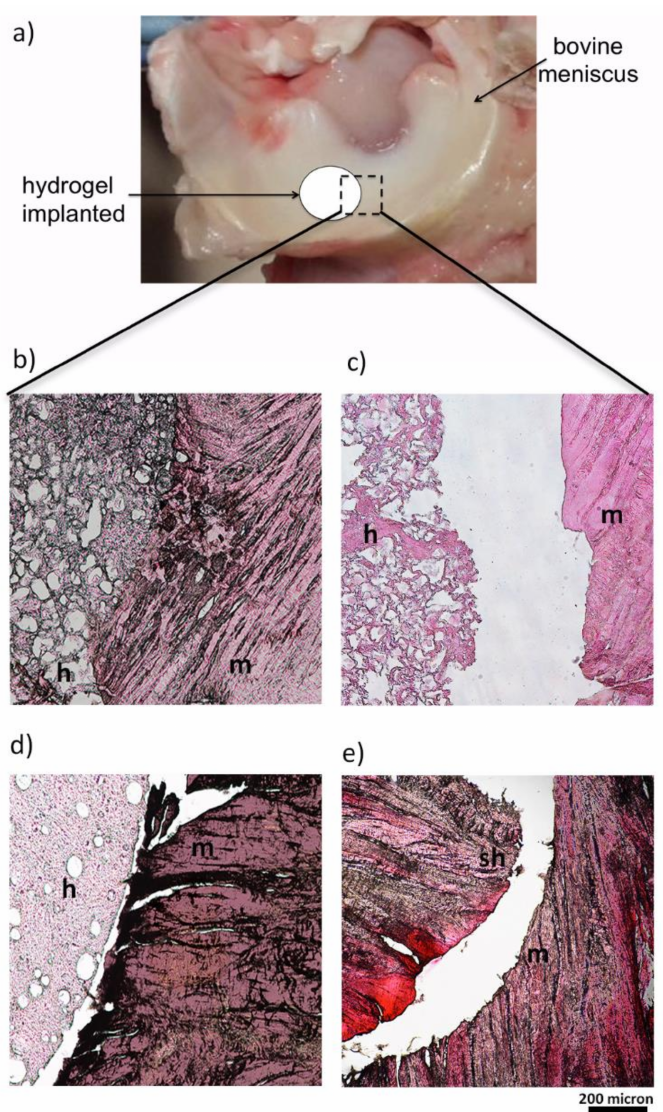
Figure 7. Ex Vivo culture model by bovine meniscus ( a ). Histology images (H&E) representing the junctions between the meniscal explants and the gelatin/PVA porous hydrogel ( b ), PVA porous hydrogel ( c ), non-porous gelatin/PVA hydrogel ( d ), sham ( e ) after 10 days of ex vivo culture. Meniscal explants (m), hydrogels (h), and the sham (sh) are indicated in the figure. Moreover, the high porosity, combined with the addiction of gelatin in porous gelatin/PVA hydrogels, provides ground to native host cell migration, as documented by additional DAPI staining of the sections (Figure 8). Achievement of cell-free hydrogel colonization by native meniscal cells is a must to set solid bases for construct/native tissue integration, one of the major issues in the development of meniscal